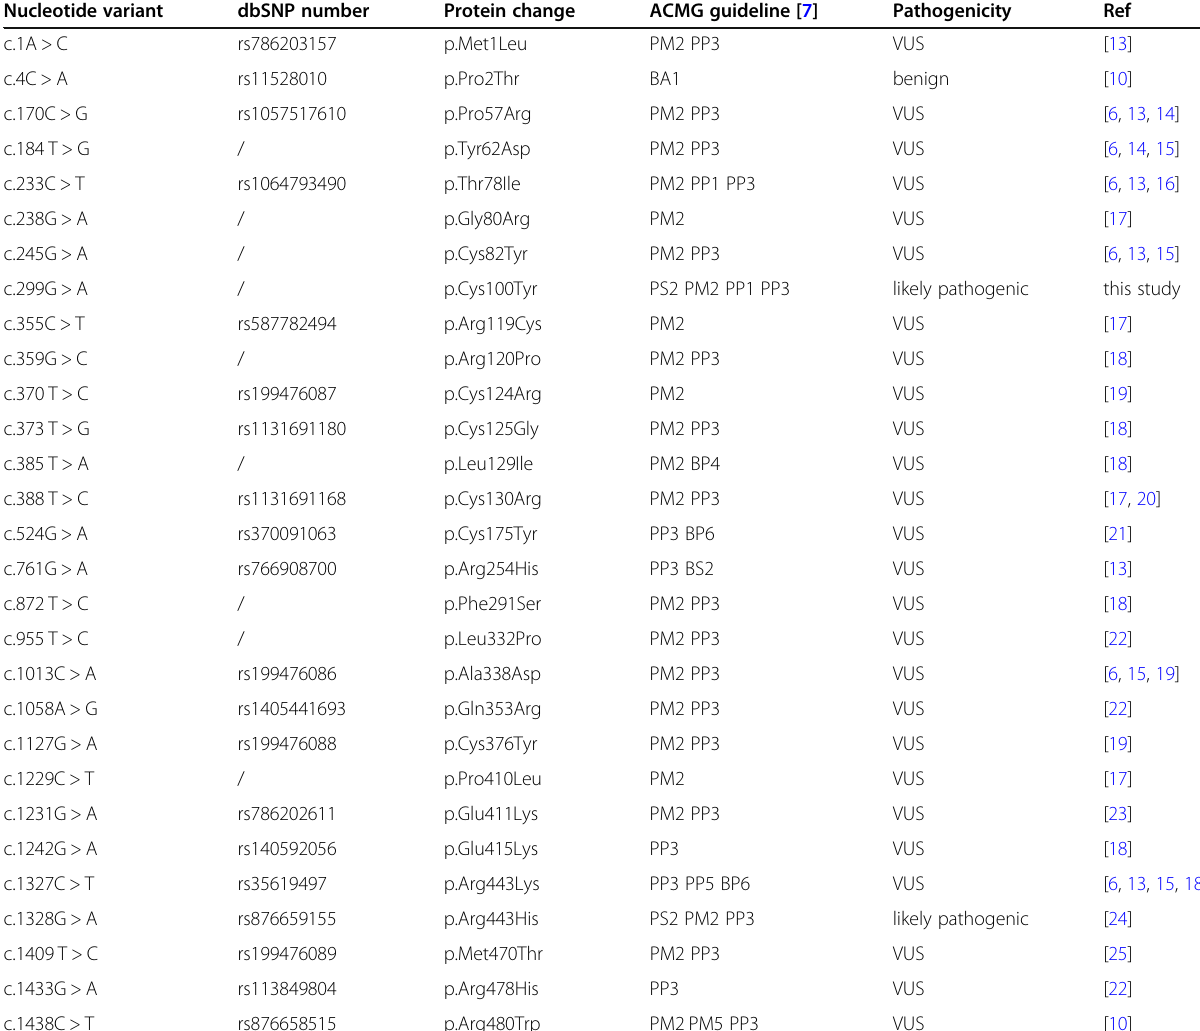
Table 1 Missense Variants of BMPR1A gene identified in JPS